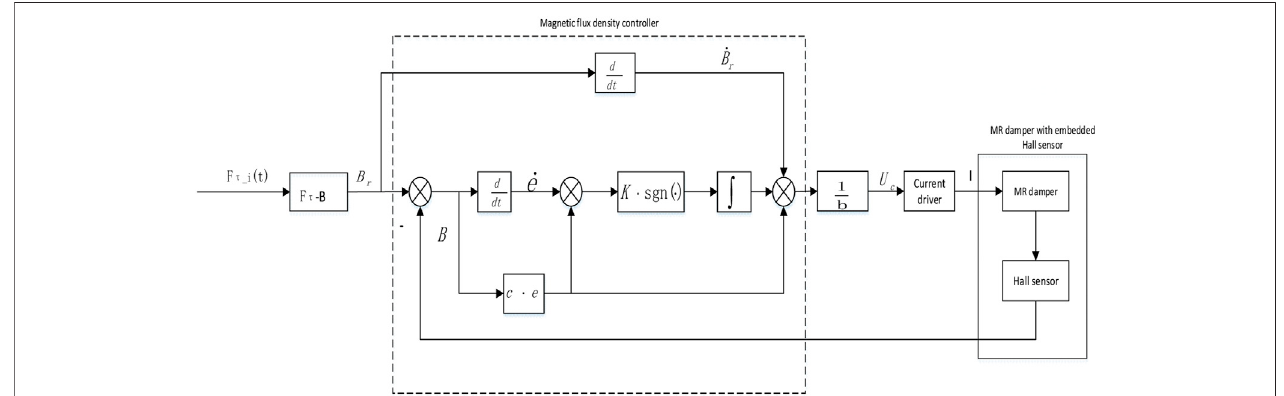
FIGURE 8 | Control schematic diagram of MR impact buffer control system based on the CTSMC.